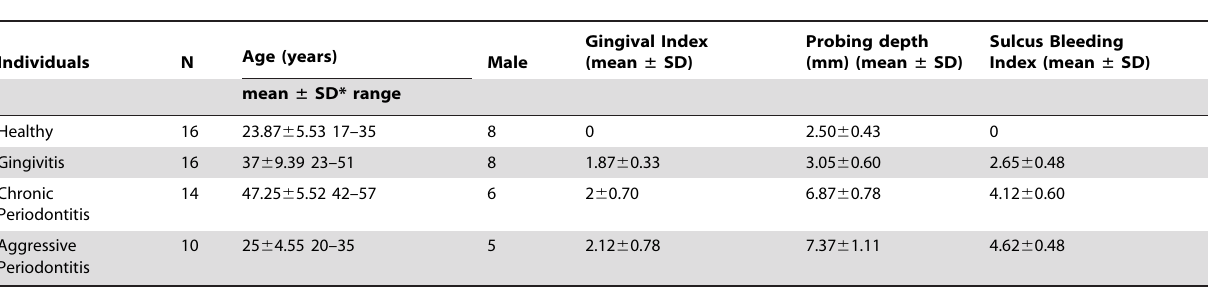
Table 1. Clinical profile of gingival biopsy sites.